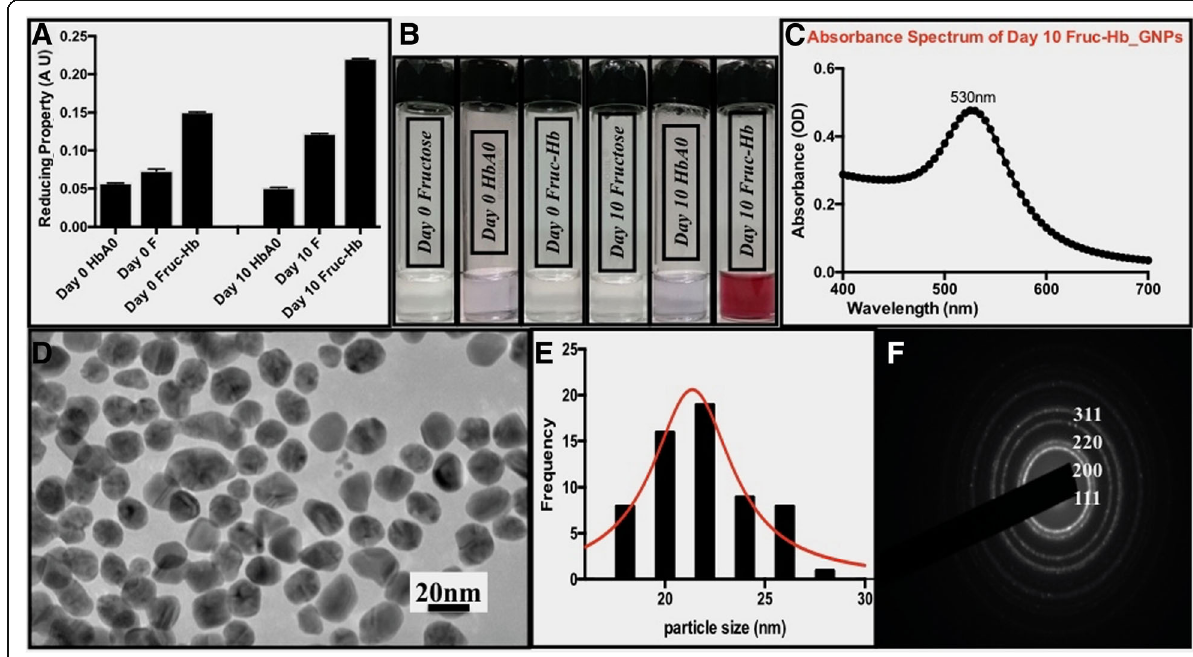
Fig. 2 Characterisation of AGE formation and GNP synthesis from HbA0, fructose and Fruc-Hb samples. a Reducing properties of HbA0, fructose, Fruc-Hb of 0 and 10 days of incubation respectively measured by the ferric ion reduction test. b Photographs of GNPs synthesised from the respective samples. c UV-Visible absorption spectrum for the day10 Fruc-Hb_GNPs. d Transmission electron micrograph of the day10 Fruc- Hb_GNPs (scale bar: 20 nm). e Size distribution of the particles and f SAED for the